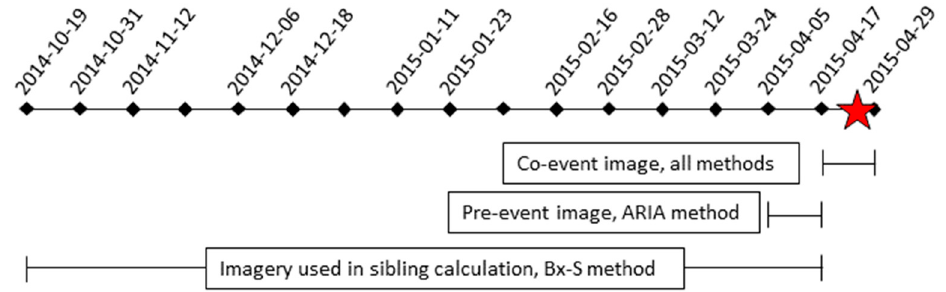
Figure 6. Timeline of Sentinel-1a image acquisition for the study area (see Figure 1) over the months preceding the Gorkha earthquake (red star), showing the imagery used in each method. Black diamonds show satellite overpasses at intervals of 12 days. Those where imagery was acquired are labelled with dates.